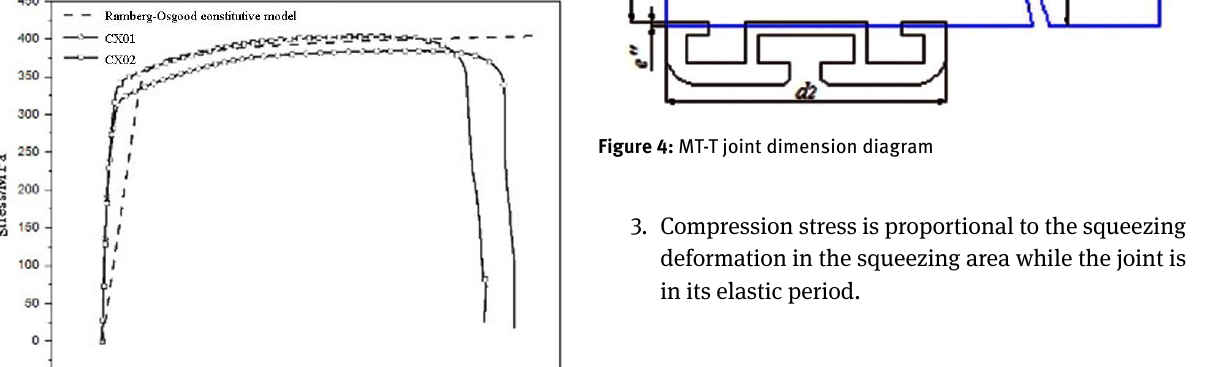
They are tested by electronic universal testing machine.